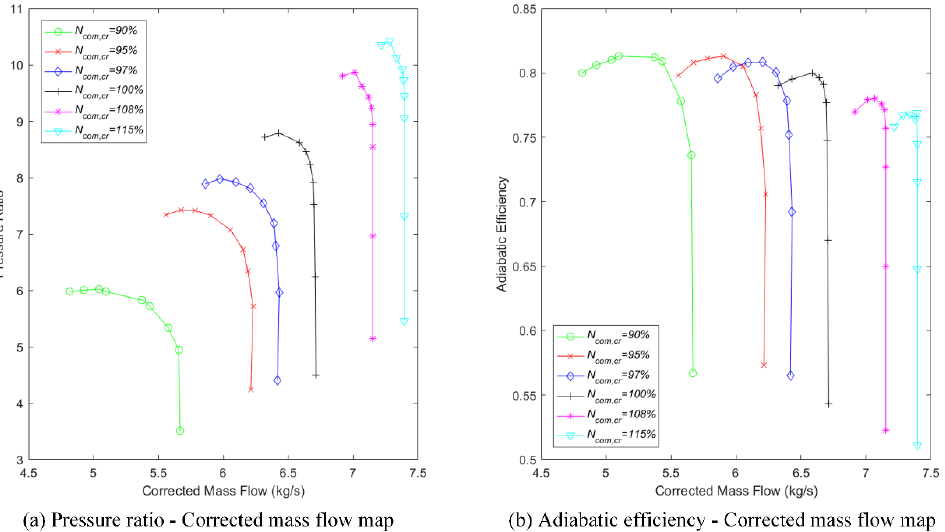
Figure 2. ( a ) The pressure ratio – corrected mass flow map; ( b ) the adiabatic efficiency – corrected mass flow map.